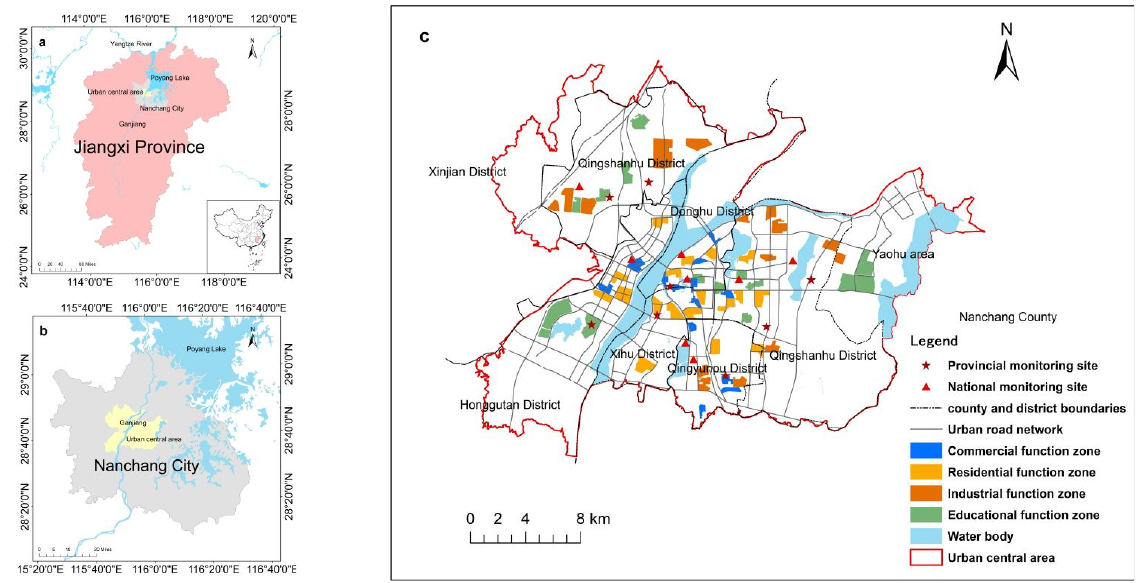
Figure 1. Location of the study area: ( a ) location of Jiangxi Province in China; ( b ) location of urban central area; ( c ) monitoring sites and land function zones in the study area.